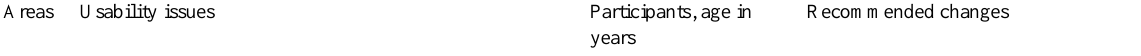
Add axes to figure labels.Doctor, 43Lack of axes labels for figures. Add a note to doctors on the page before the start of no age given, screens meant to be shared with patients alerting them 28, to share upcoming screens. Provide proper training/ori- entation prior to